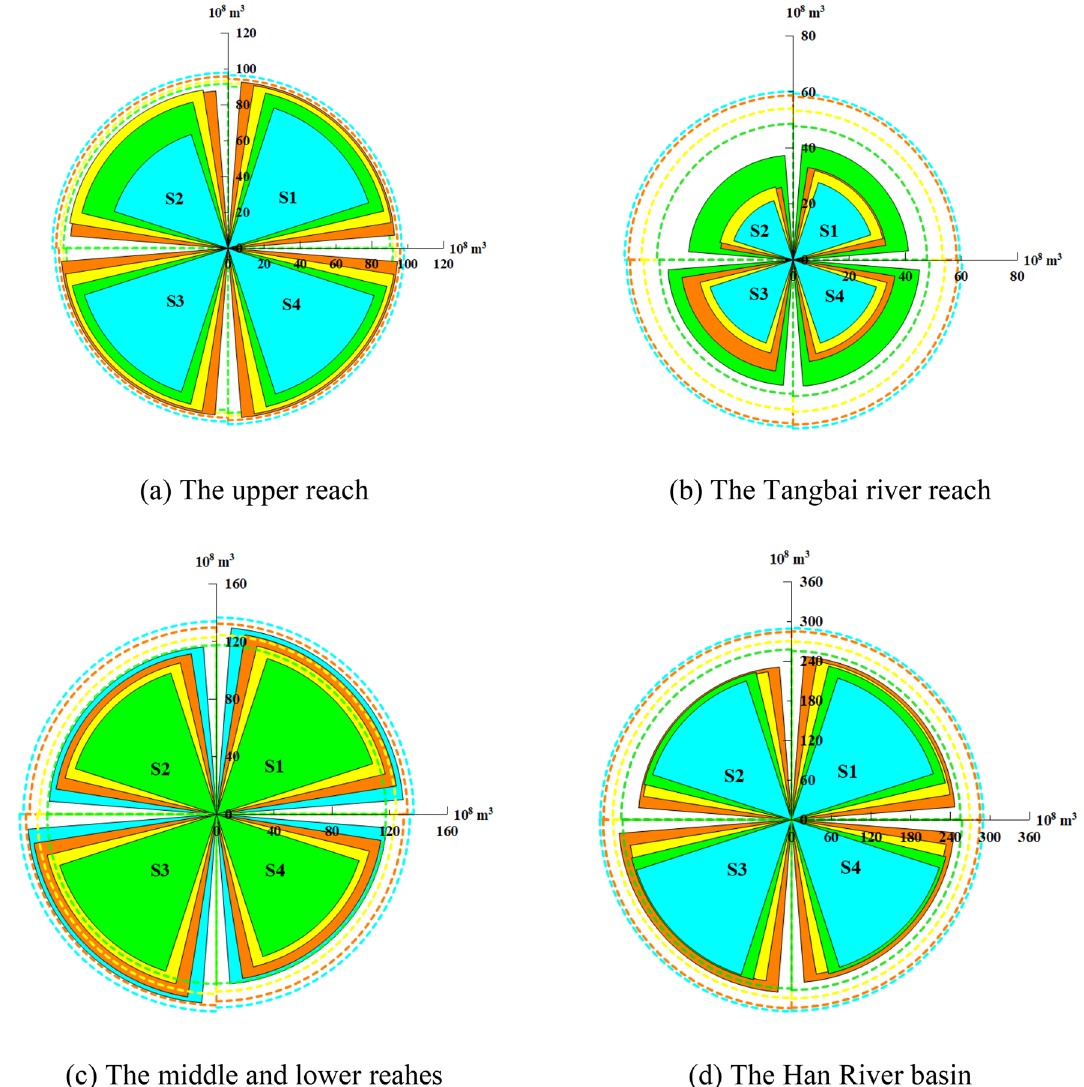
Figure 8. Diagram of water supply and demand under different scenarios in each area, on which and represent the amount of allocated water and water demand at 50%, 75%, 90% and 95% frequency level, respectively. (This figure is generated by Origin2020 software. URL link: https:// www. origi nlab. com/